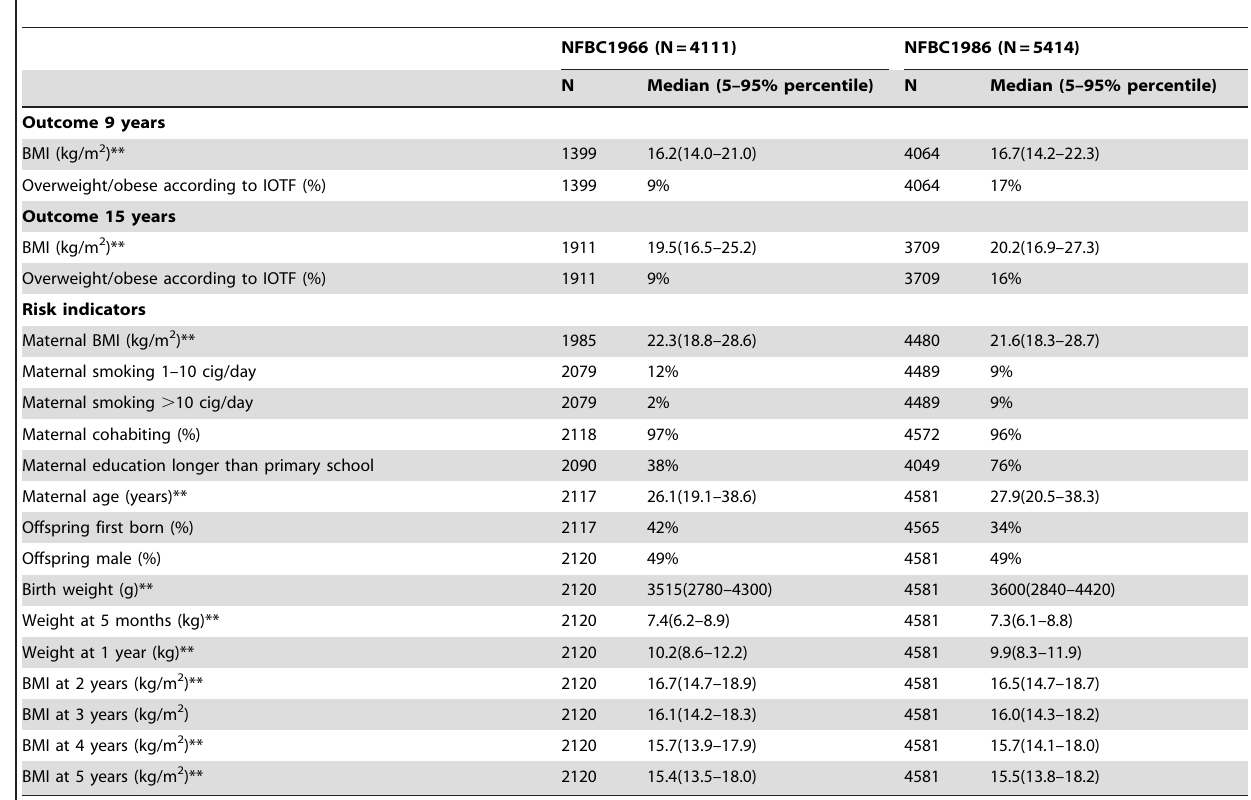
Table 1. Medians (5% and 95% percentiles) and percentages of outcomes and risk indicators in the NFBC1966 and